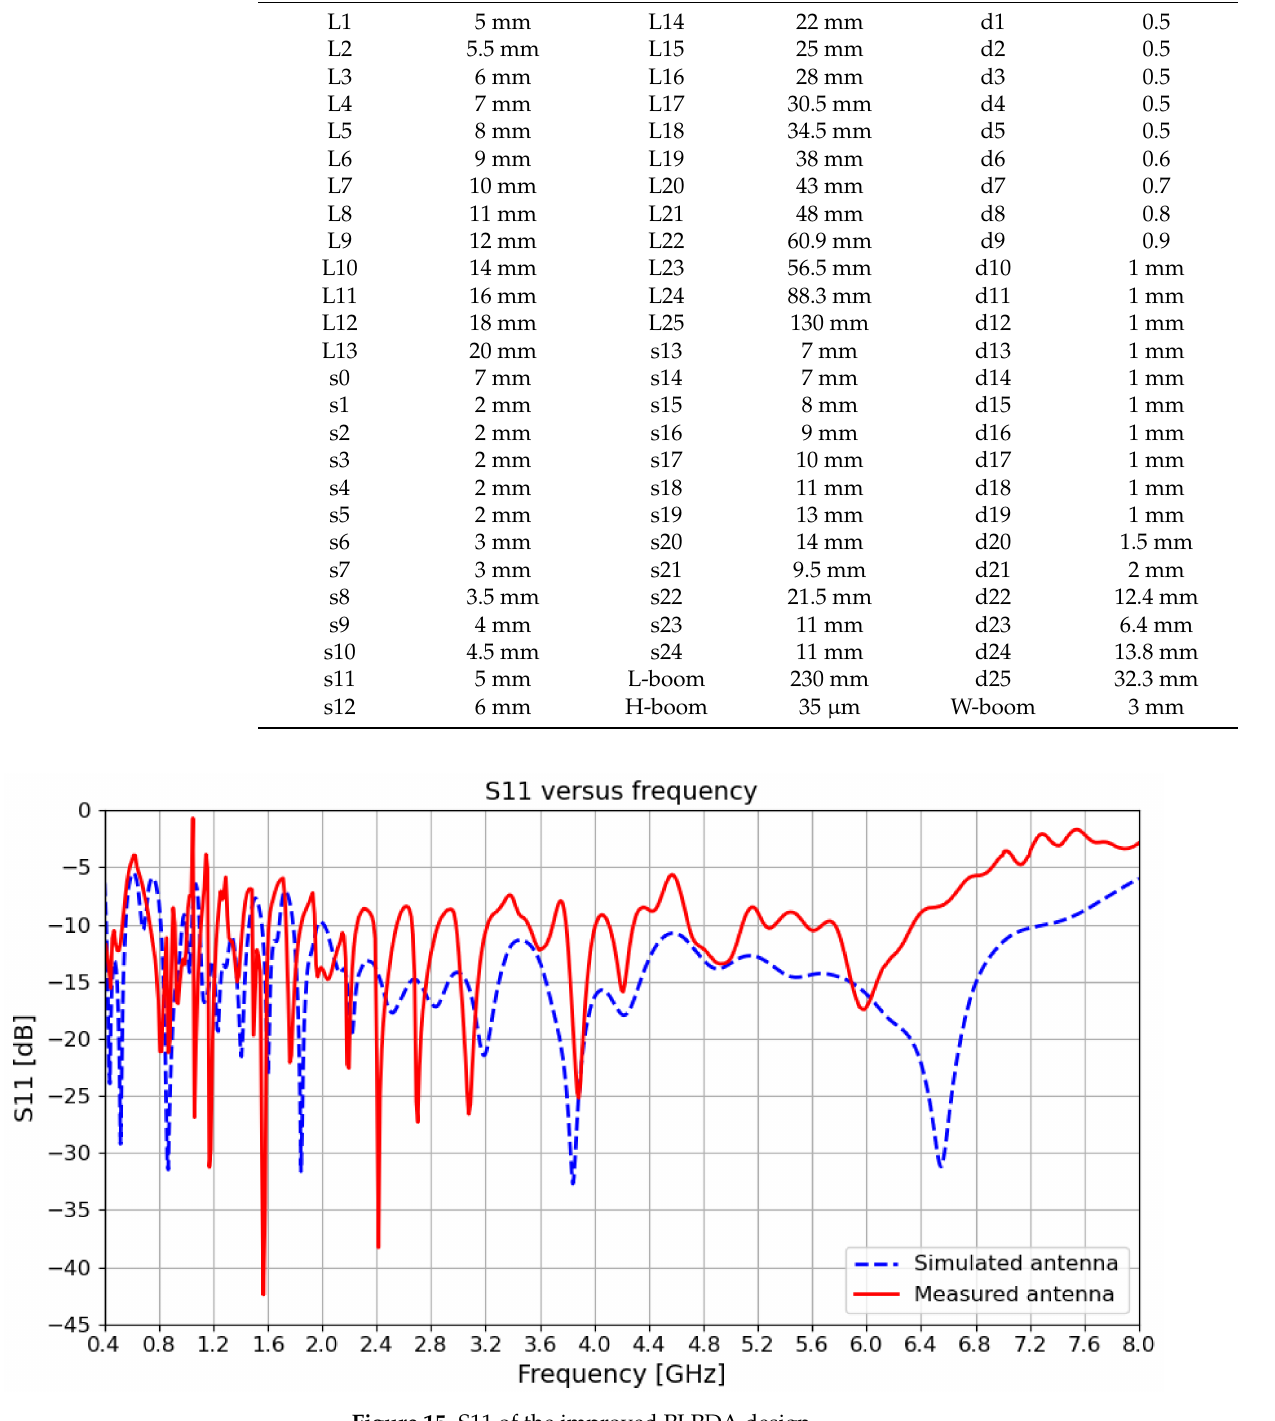
Figure 15. S11 of the improved PLPDA